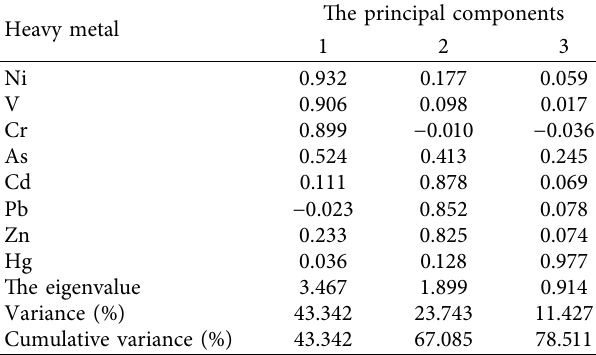
Table 3: Principal component analysis results of soil heavy